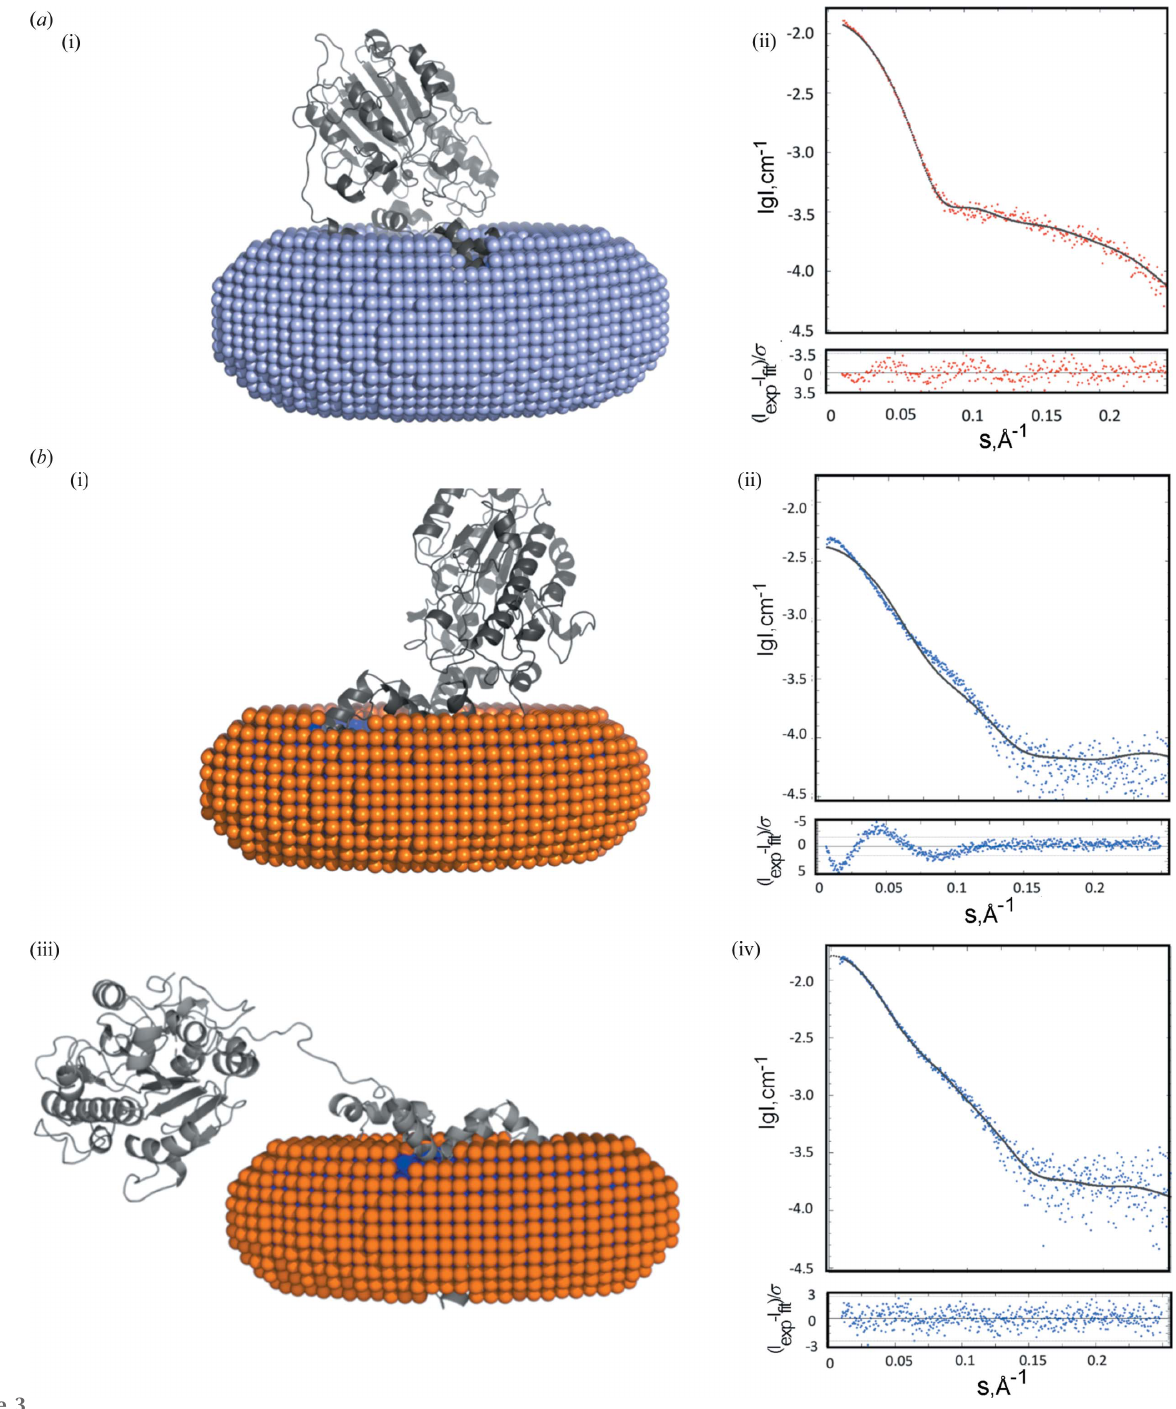
Figure 3 MEMPROT and DADIMODO modelling results. ( a ) Model and scattering fit for the EptA:DDM complex and ( b ) the EptA:DPC complex. ( a ) (i) Representative MEMPROT generated model for the EptA:DDM complex. The atomic structure of EptA is represented in cartoon mode and coloured grey. The DDM corona around EptA is represented as pale blue spheres. ( a ) (ii) Comparison of the SAXS experimental result (red dots) with the MEMPROT calculated scattering curve (black solid line). The lower inset shows the error-weighted residual difference plot for the experimental SAXS model and the MEMPROT generated model (red dots). ( b ) (i) Representative MEMPROT generated model for the EptA:DPC complex. The atomic structure of EptA is represented in cartoon mode and coloured grey. The DPC corona around EptA is represented as orange spheres. ( b ) (ii) Comparison of the SAXS experimental result (blue dots) with the MEMPROT calculated scattering curve (black solid line). The lower inset shows the error-weighted residual difference plot for the experimental SAXS data and the MEMPROT generated model (blue dots). ( b ) (iii) Model of the EptA:DPC complex obtained with DADIMODO , assigning the soluble domain and transmembrane domain as rigid bodies connected by a flexible bridging helix and linker region. The atomic structure of EptA is represented in cartoon mode and coloured grey and the DPC corona around EptA is represented as orange spheres. ( b ) (iv) The lower inset shows the error-weighted residual difference plot for the experimental SAXS data and the DADIMODO generated model (blue